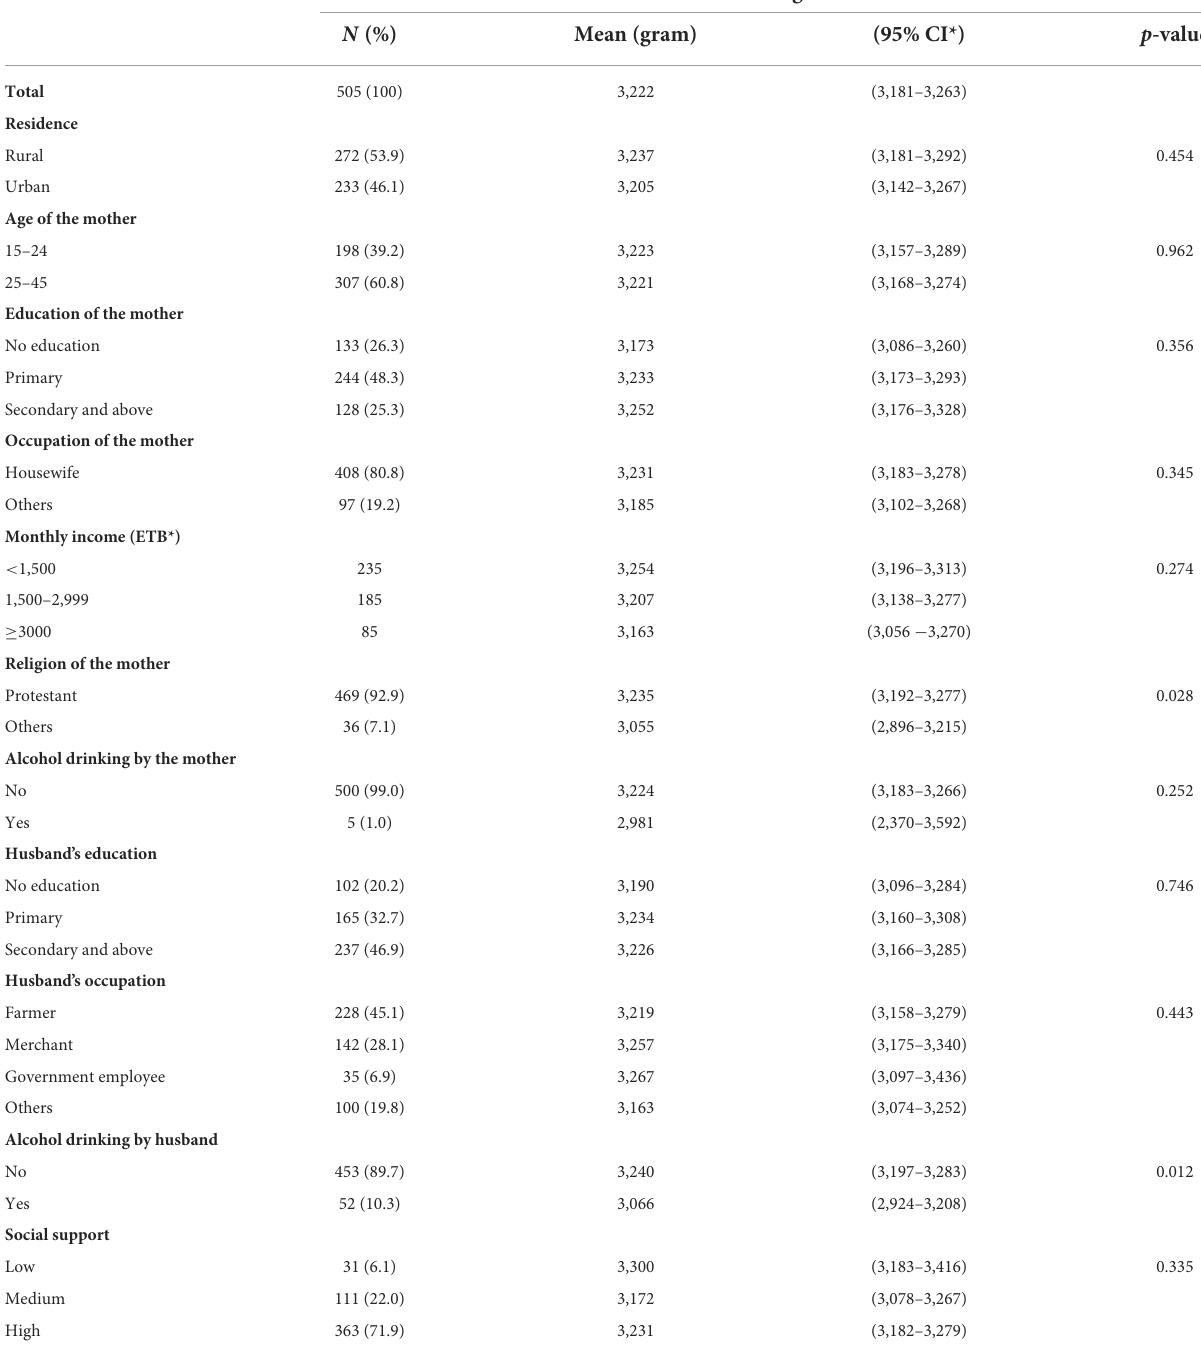
TABLE 2a Mean birth weight of babies by socio-demographic characteristics of their mothers in Wondo Genet district, Ethiopia,